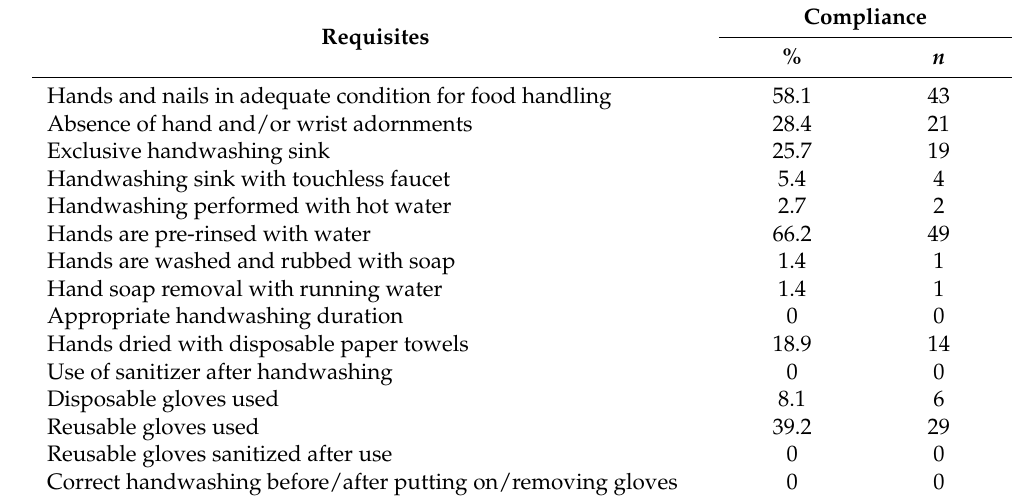
Table 4. Hand hygiene practices compliance